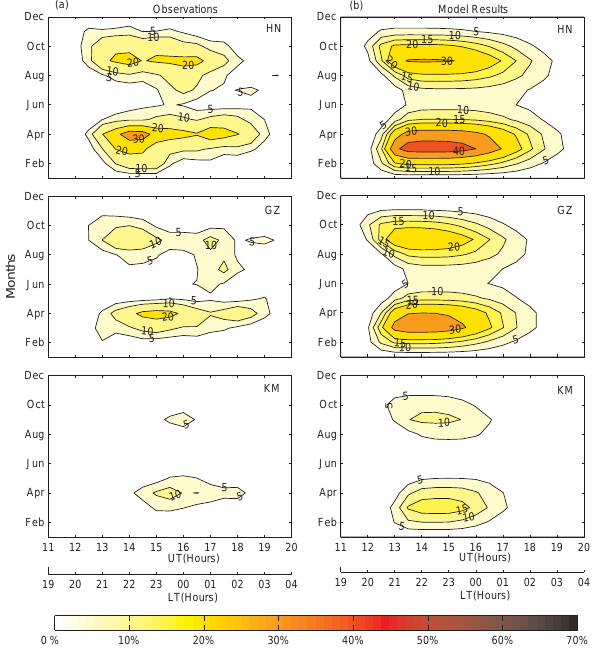
Figure 6. The contours of the percentage occurrences of scintil- lation calculated using the second method under the condition of S4 > 0.5 as a function of time and season are shown for (a) the observations and (b) the predictions of the CMSOP at the three sta- tions for